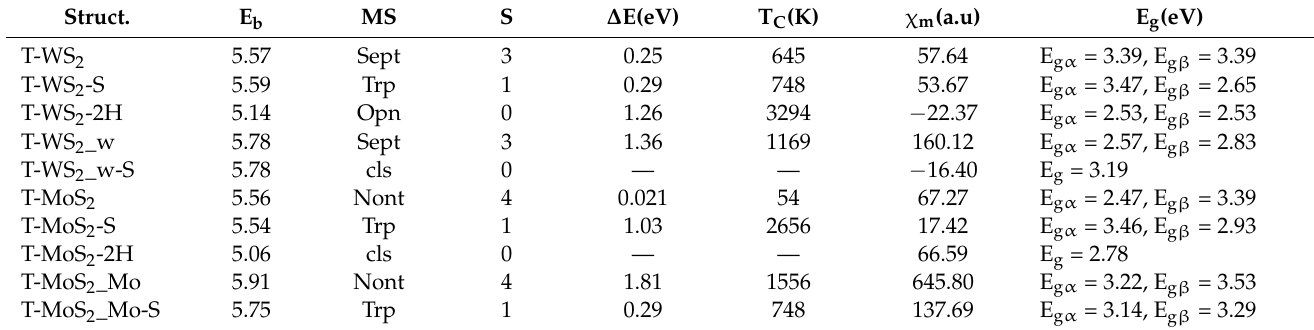
Table 1. The binding energy (E b ), magnetic state (MS), spin (S), and the modules of the difference between the antiferromagnetic ground state energy and the ferromagnetic ground state energy ( ∆ E). The last three columns give Curie Temperature (T C ), the magnetic susceptibility( χ m ), and the energy gap (E g